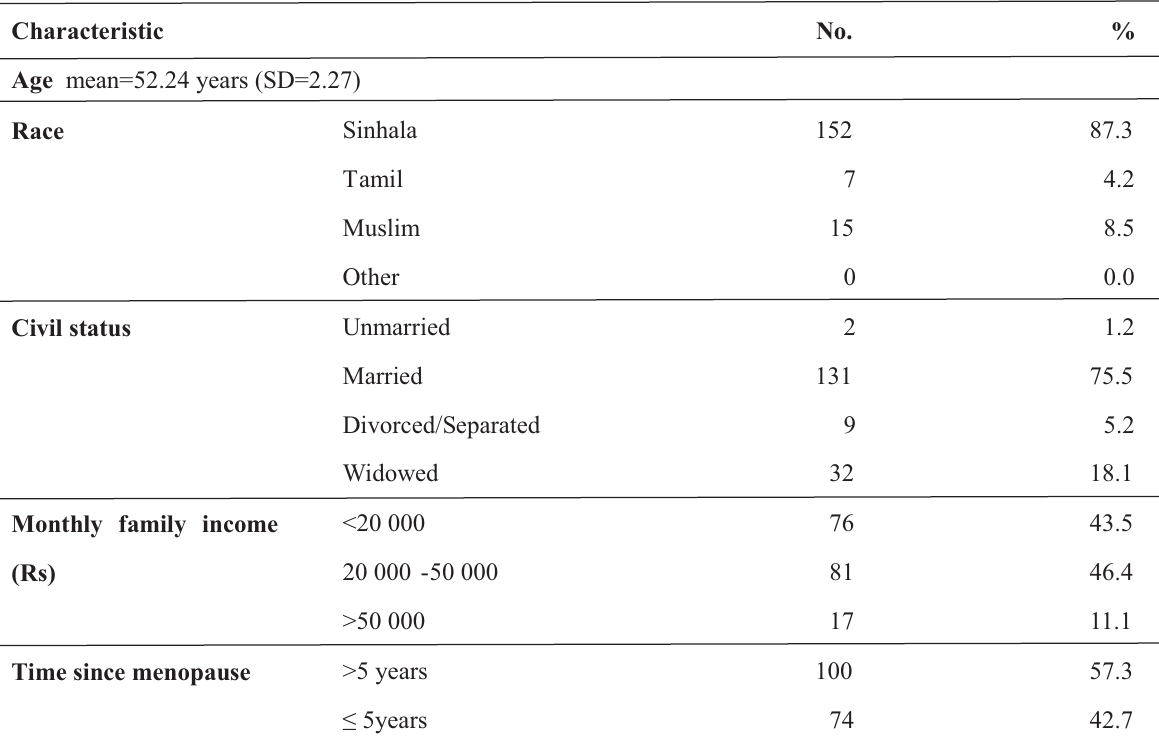
Table 1: Socio-demographic profile of the participants for factor analysis (N=174) Characteristic No. % Age mean=52.24 years